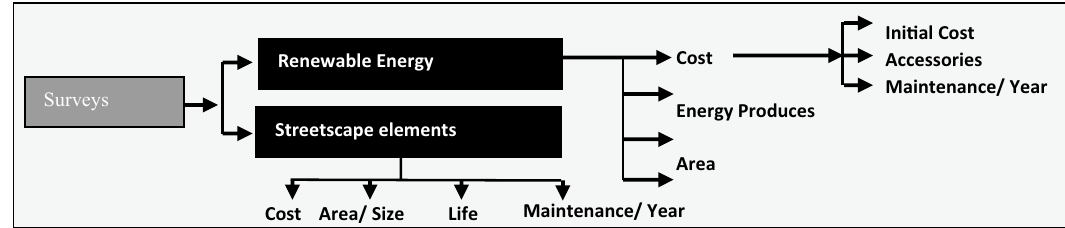
Figure 4. The aspects of the two cross-sectional surveys’ used in this